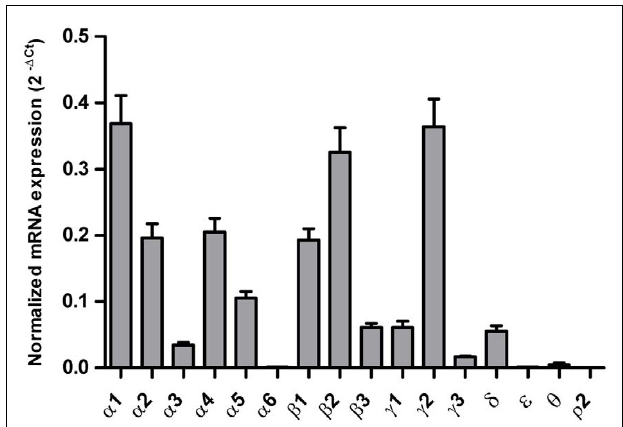
FIGURE 5 | Expression of GABA A channel subunit mRNAs in the prefrontal cortex of controls ( n = 15). The mRNA level of each subunit was normalized to reference genes ACTB and RPLP0 and presented as mean ±